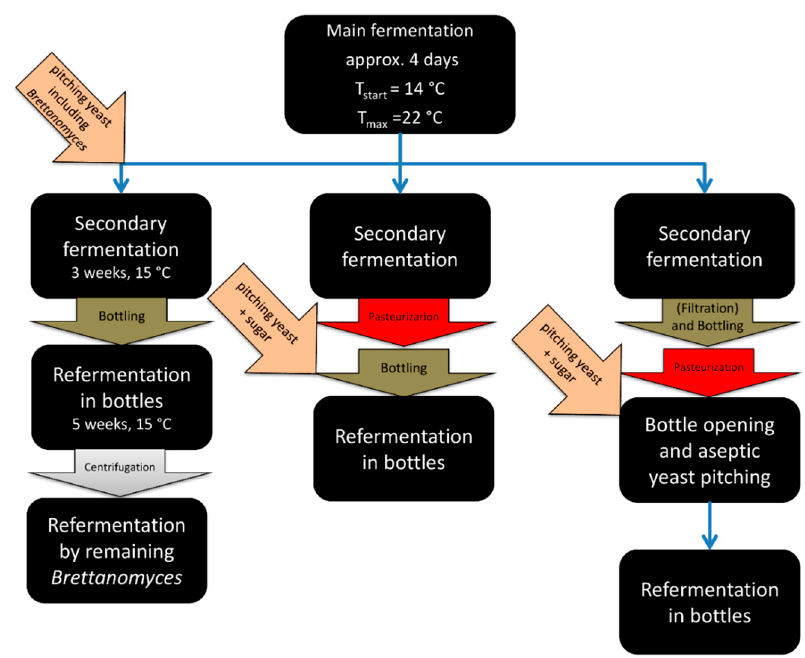
Figure 1. Practical approaches for production of bottle-conditioned beers.